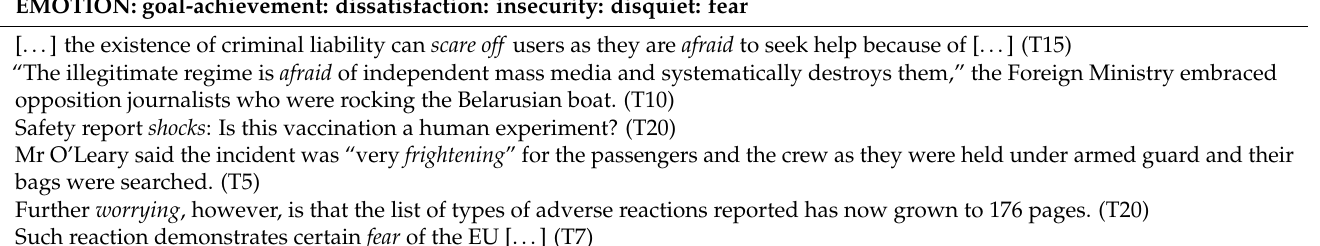
Table A1. Typical Examples of Emotion and Opinion